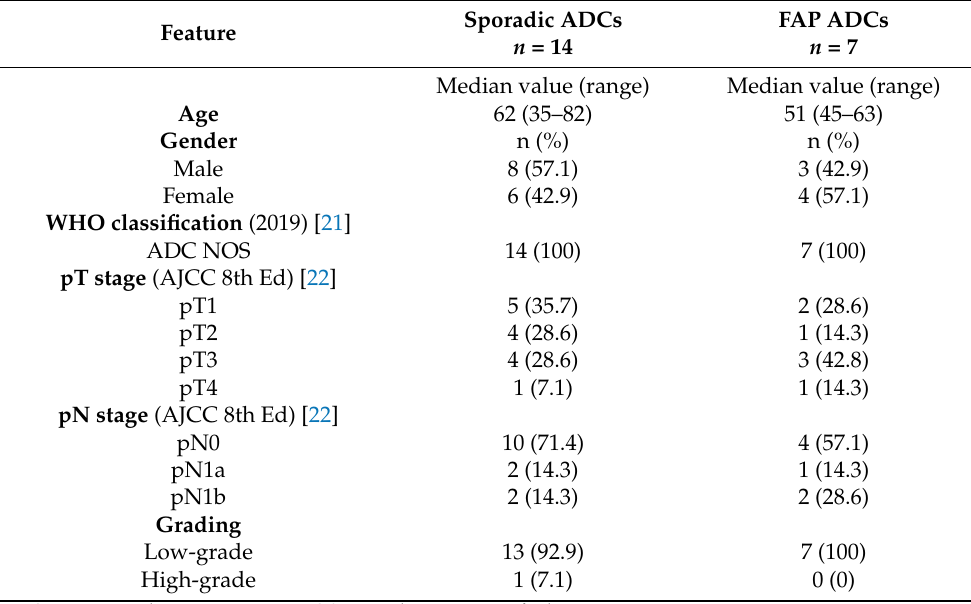
Table 1. Clinicopathological characteristics of sporadic and Familial Adenomatous Polyposis (FAP) colorectal cancer